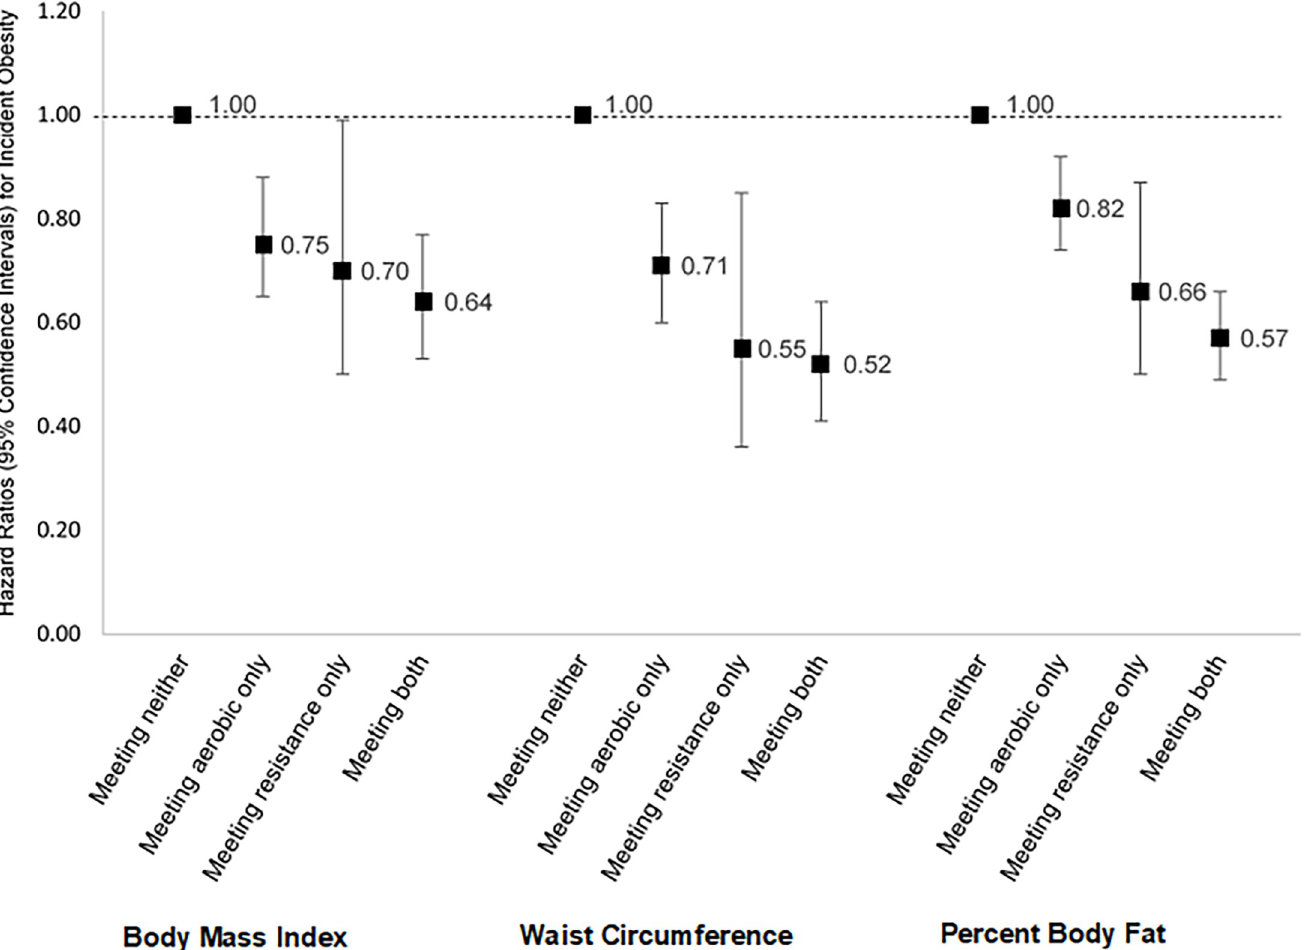
Fig 2. Hazard ratios for incident obesity by whether participants met the aerobic and/or resistance exercise guidelines. Hazard ratios are depicted by black boxes, and 95% confidence intervals by whiskers. Participants were categorized into 4 groups based on whether they met neither guideline, aerobic exercise guidelines only, resistance exercise guidelines only, or both aerobic and resistance exercise guidelines. The group of participants who met neither guideline served as the reference. The model was adjusted for age, sex, examination year, current smoking, and heavy alcohol drinking. The cases/participants for the body mass index analysis were 357/4,075, 323/4,682, 36/536, and 158/2,645 for the neither, aerobic only, resistance only, and both groups, respectively. The cases/participants for the waist circumference analysis were 301/3,067, 290/3,769, 23/450, and 112/2,204 for the neither, aerobic only, resistance only, and both groups, respectively. The cases/ participants for the percent body fat analysis were 588/2,577, 756/3,601, 55/397, and 284/2,158 for the neither, aerobic only, resistance only, and both groups, respectively.